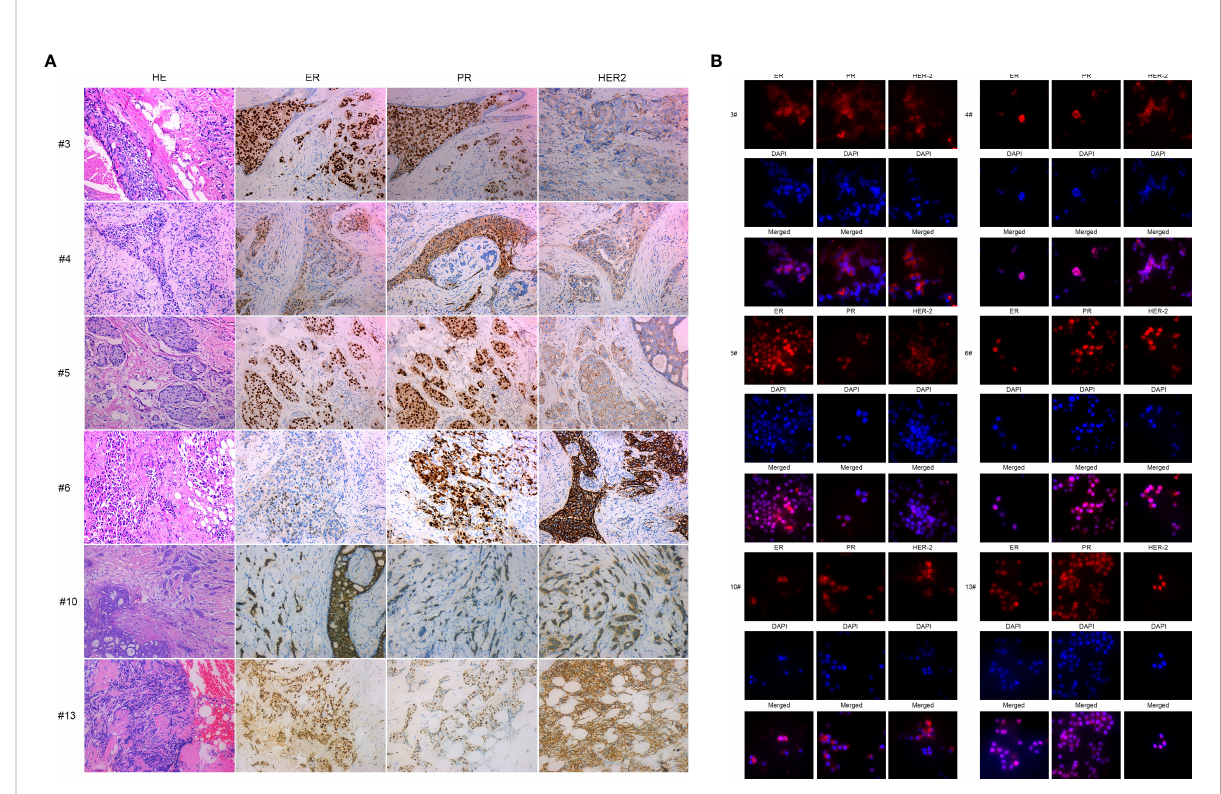
FIGURE 2 IHC and immuno fl uorescence staining of primary breast cancer cells: BC3, BC4, BC5, BC6, BC10, and BC13. (A) IHC staining of ER, PR, and HER2 of BC3, BC4, BC5, BC6, BC10, and BC13 breast cancer tissue sections. (B) Immuno fl uorescence staining of ER, PR, and HER2 in the primary breast cancer cells BC3, BC4, BC5, BC6, BC10, and BC13.